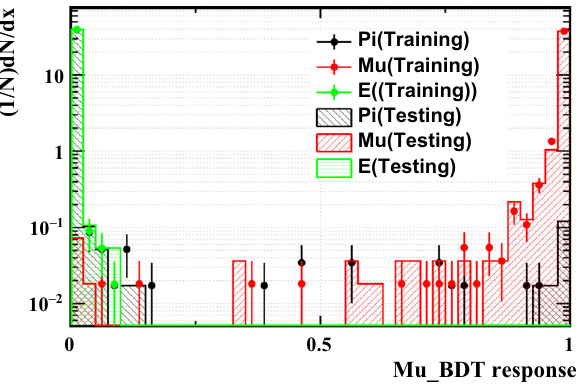
Fig. 13 Muon BDT response of e − , μ − and π + at 40 GeV (training and test